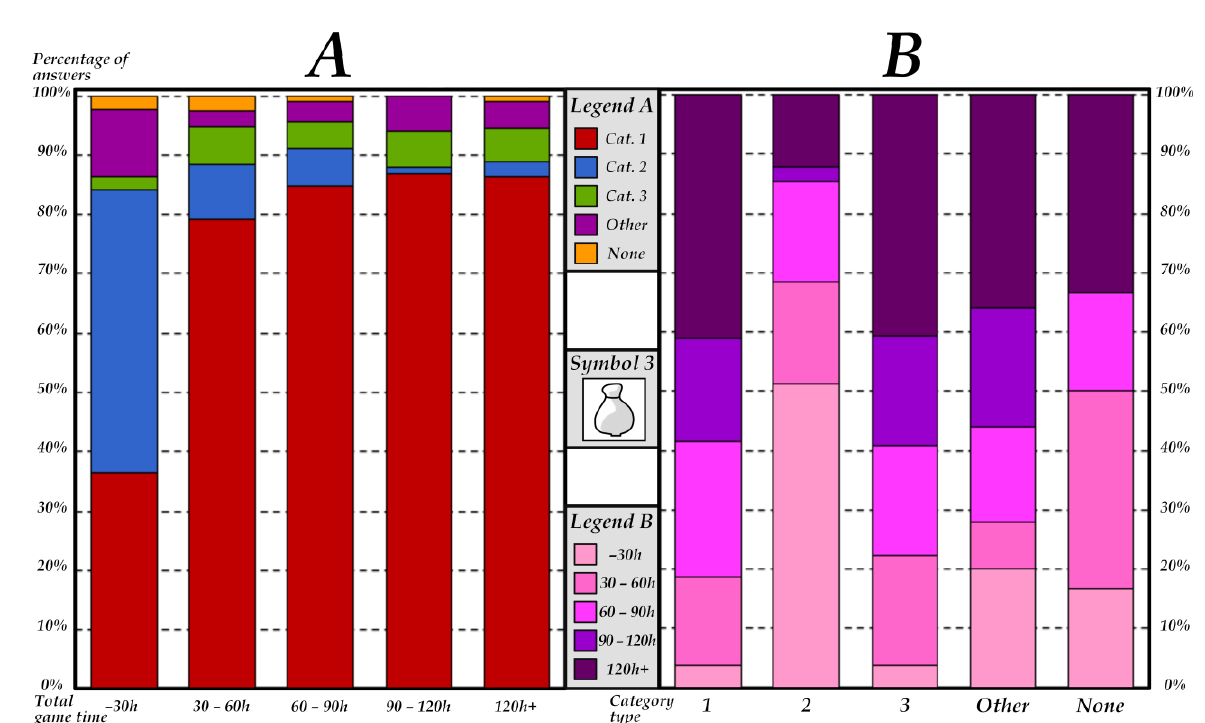
Figure 6. Cumulative charts presenting a percentage of individual categories of symbol 3 interpretation, divided according to the time spent on playing Valheim ( A ) and including individual groups (time spent on playing), divided according to interpretation categories ( B ).